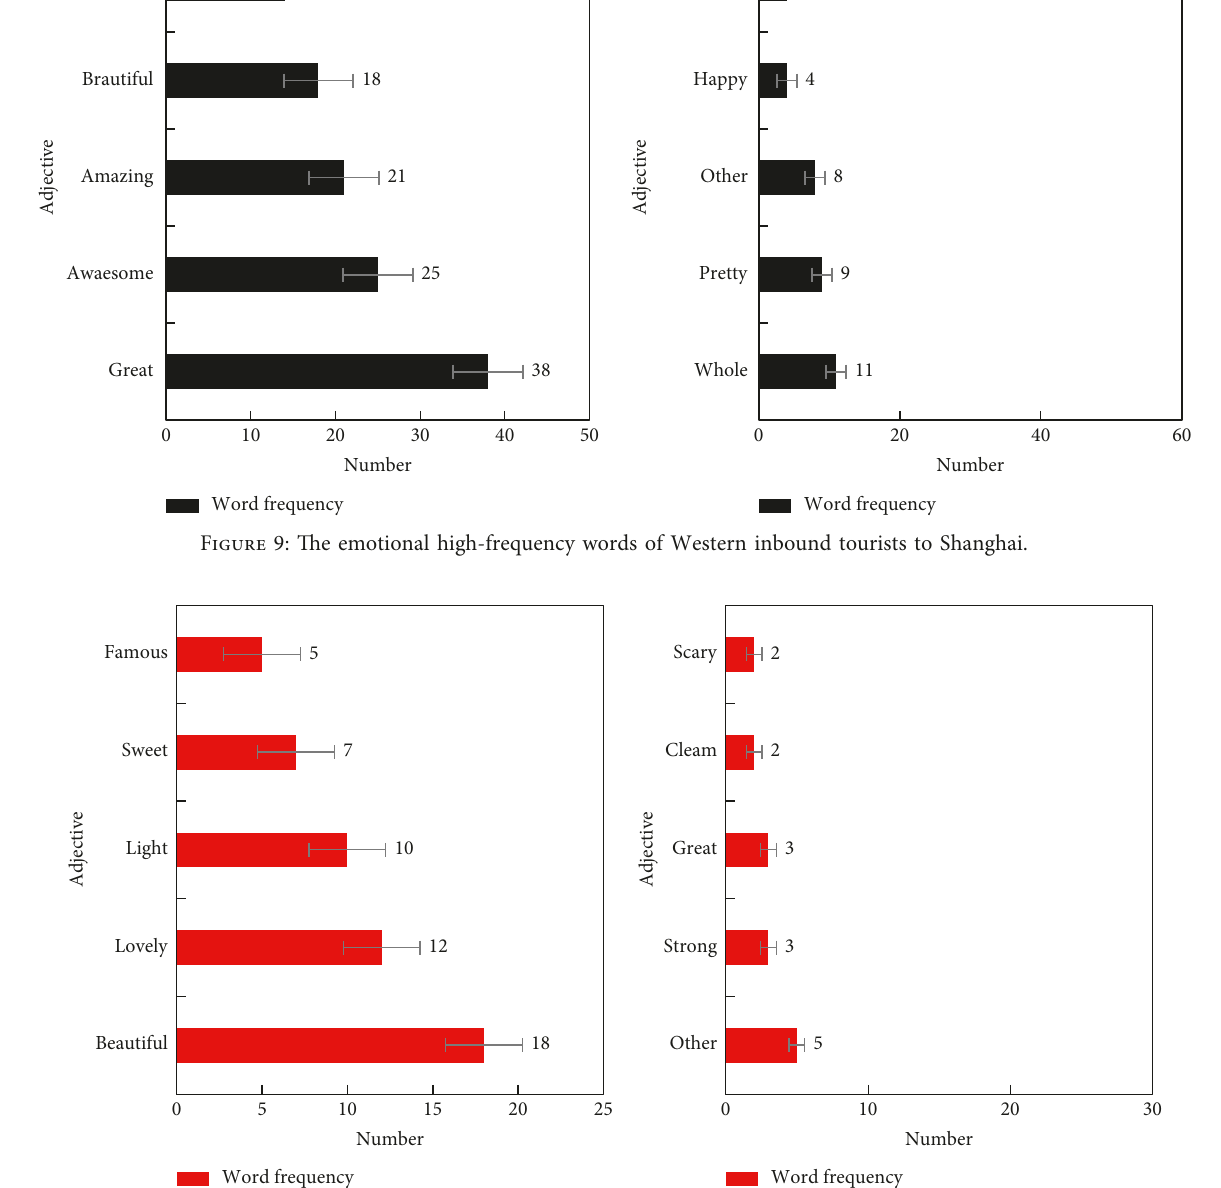
Figure 10: High-frequency words of East Asian inbound tourists’ emotion towards Shanghai’s